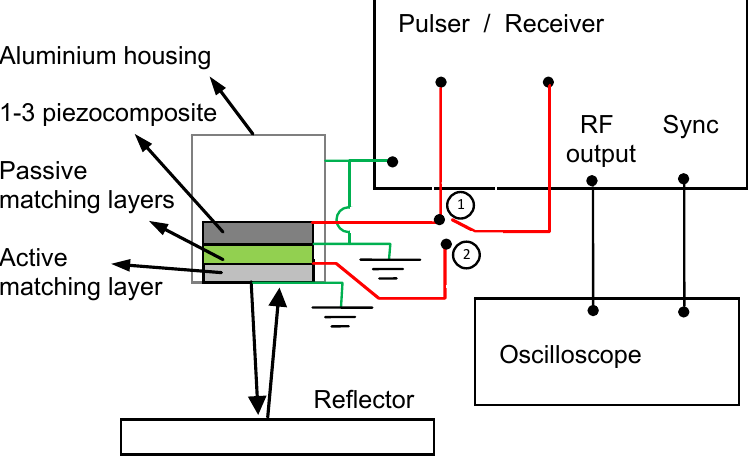
Figure 2. Schematic representation of some of the possible electrical connections of the air-coupled transducer with a piezoelectric matching layer. Switch is in position 1: transducer works in pulse-echo mode of operation (transmit and receive with the piezocomposite). Switch in position 2: transducer works in pitch-catch mode of operation: transmit with the piezocomposite and receive with the ferroelectret matching layer.